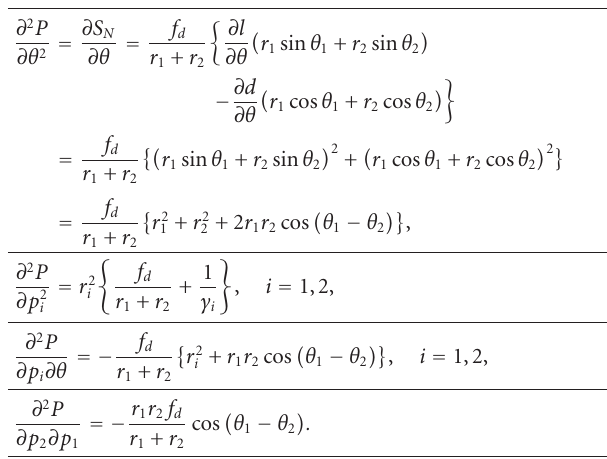
Table 1: Hessian matrix of the potential P.